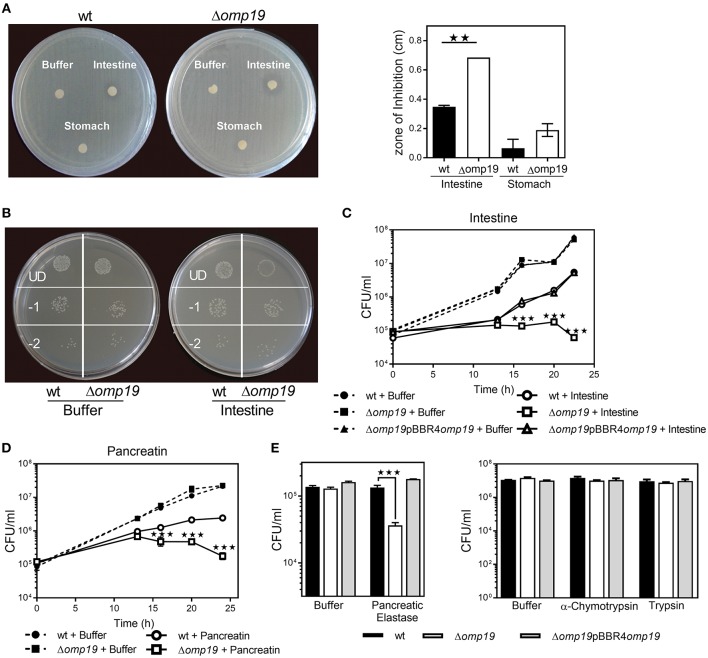
Omp19 protects B. abortus against the action of pancreatic proteases. (A) 1 × 108 CFU of wt and Δomp19 B. abortus were spread on TSA plates supplemented with antibiotics. Five-mm filter-disk were impregnated with either PBS, intestine- or stomach-extract and placed on the agar surface. The plates were incubated at 37°C for 72 h and afterwards the diameter of the zones of inhibition were determined (diameter of no growth zone minus diameter of the disk). (**p < 0.01 vs. wt B. abortus + intestine extract). (B) Representative picture of a plate with wt and Δomp19 B. abortus treated with buffer or intestine extract. Plated undiluted (UD) or after serial dilutions: 1/10 (−1) and 1/100 (−2). (C)
wt, Δomp19 or Δomp19pBBR4omp19 B. abortus strains (1 × 105 CFU/ml) were incubated with PBS or intestine extract at 37°C. Live bacteria (CFU/ml) were determined after 12, 16, 20, and 24 h of incubation by serial dilutions plating (***p < 0.001 vs. wt B. abortus + intestine extract). (D)
wt and Δomp19 B. abortus (1 × 105 CFU/ml) were incubated with buffer (0.5% ClNa) or pancreatin (2 mg/ml). Live bacteria (CFU/ml) were determined after 12, 16, 20, and 24 h of incubation by plating serial dilutions on TSA (***p < 0.001 vs. wt B. abortus + pancreatin at the same time point). (E) wt and Δomp19 B. abortus (1 × 105 CFU/ml) were incubated with buffer (10 mM Tris-HCl, pH8.8) or pancreatic elastase for 5 h or with buffer (10 mM Tris-HCl, pH7.8), α-chymotrypsin or trypsin for 24 h. Live bacteria (CFU/ml) were determined by plating serial dilutions on TSA (***p < 0.001 vs. wt B. abortus + pancreatic elastase). Results are representative of two or three independent experiments.